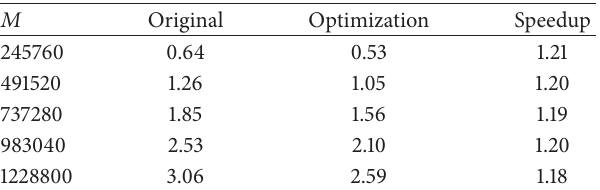
Table 4: Performance improvement for fixed 𝑁 with the optimiza- tion of constant vector multiplication and vector-vector addition.